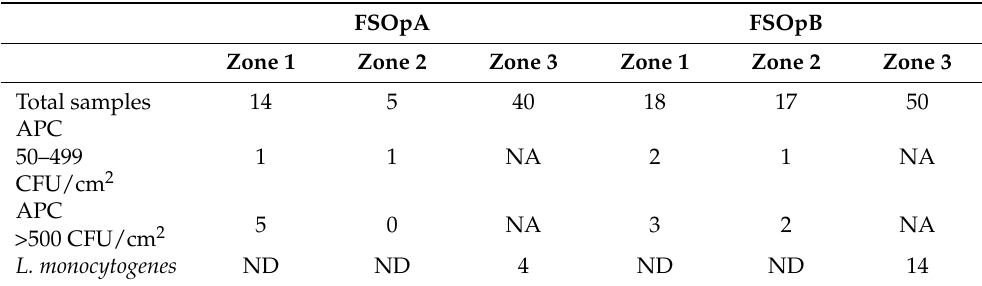
Table 3. Number of non-compliant samples for APC counts and L. monocytogenes from environmental samples for FSOp-A and FSOp-B.